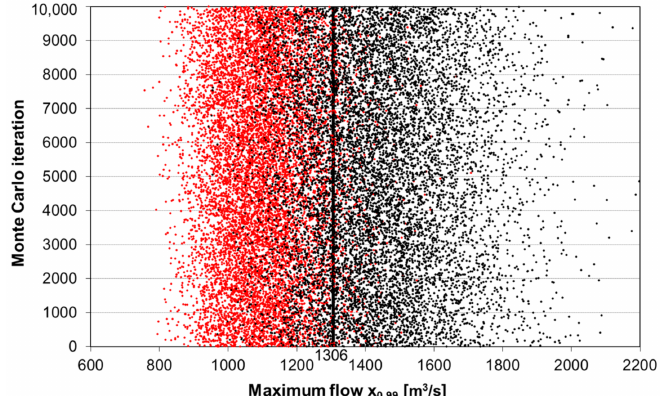
Figure 4. Realization of 68.3% confidence intervals against the true quantile value in the population. Red dots correspond to the beginnings and black to the ends of the